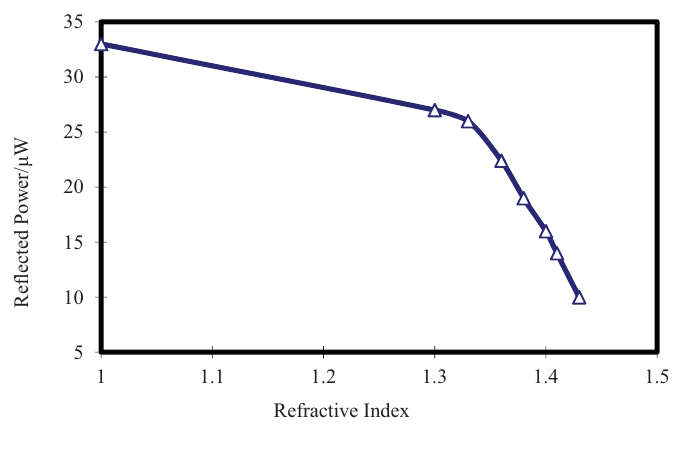
Figure 5. Reflected power of hybrid LPG/CFBG versus